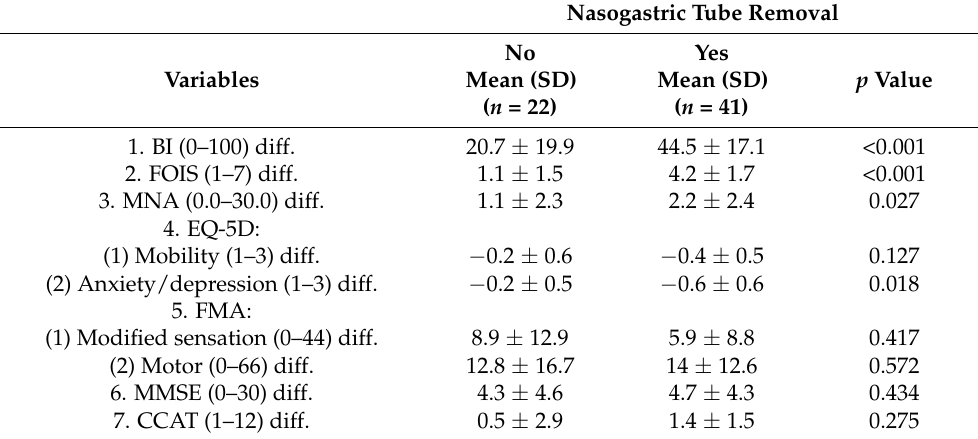
Table 4. Comparison of variables at admission and